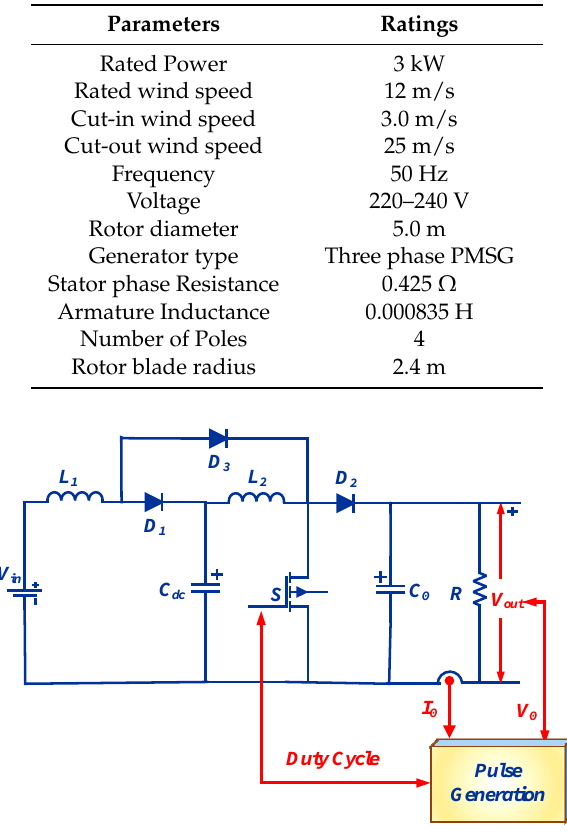
Figure 8. Simulation configuration of proposed topology.